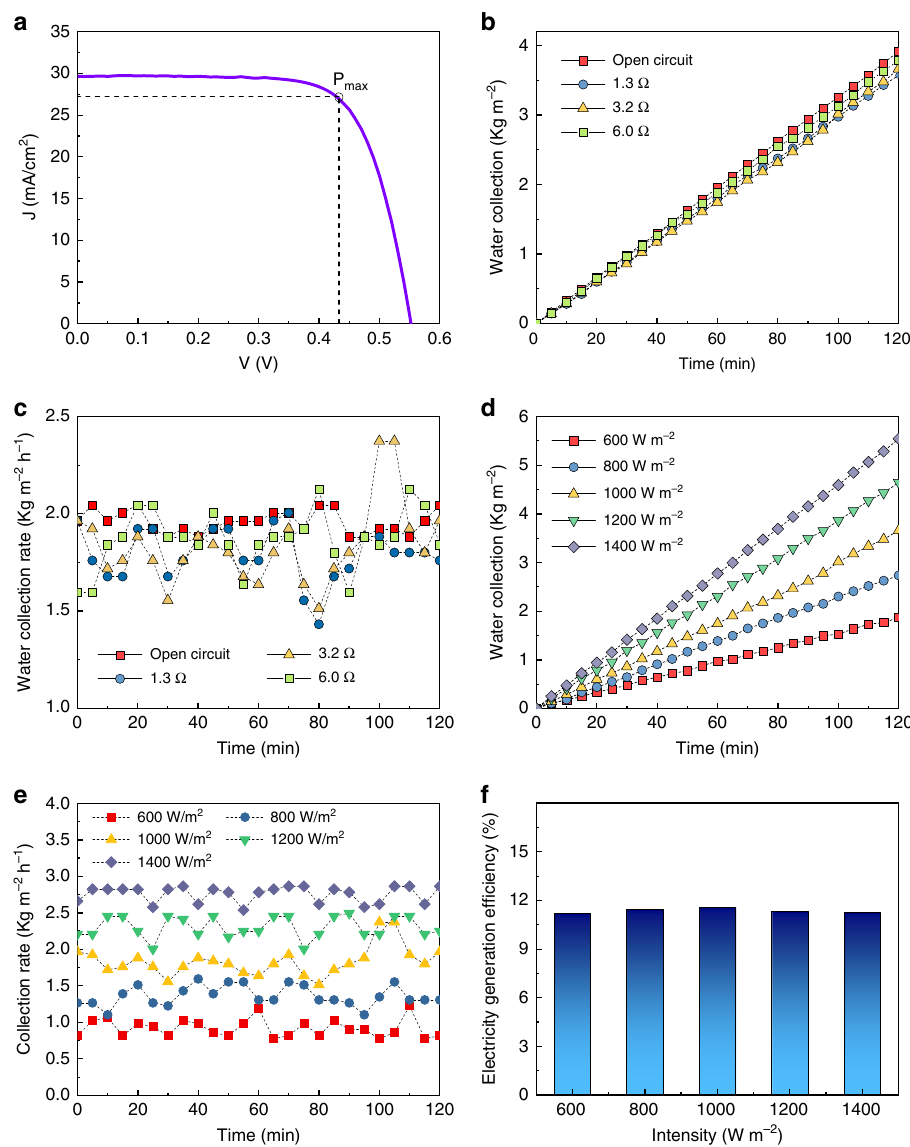
Fig. 4 Electricity and water production evaluation of the photovoltaics-membrane distillation (PV-MD) device. a J – V curve of the solar cell under one Sun illumination ( P max refers to the maximum power). b The mass change rate of the collected water and c clean water production rate at different loads of 3- stage PV-MD with dead-end mode; d the mass change rate of the collected water, e clean water production rate, and f electricity generation ef fi